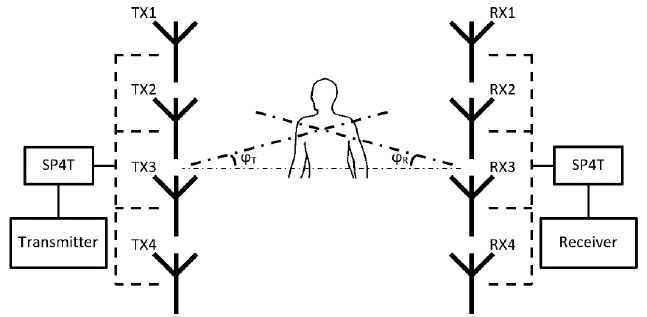
Figure 6. Conceptual scheme of the bistatic radar reported in [42].